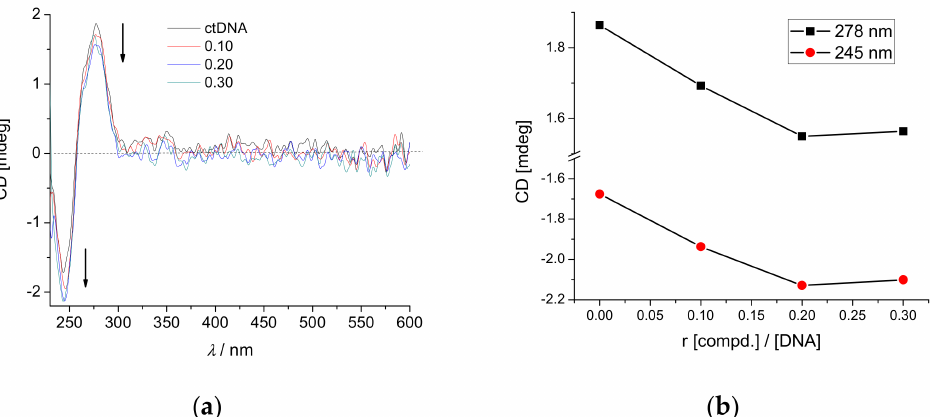
Figure 8. ( a ) CD titration of ct-DNA ( c = 2 × 10 − 5 M) with DAE-NH-Py closed at molar ratios r = [compound]/[DNA]; ( b ) dependence of CD maxima at 245 nm and 278 nm on a ratio r. Done at pH 7.0, buffer sodium cacodylate, I = 0.05